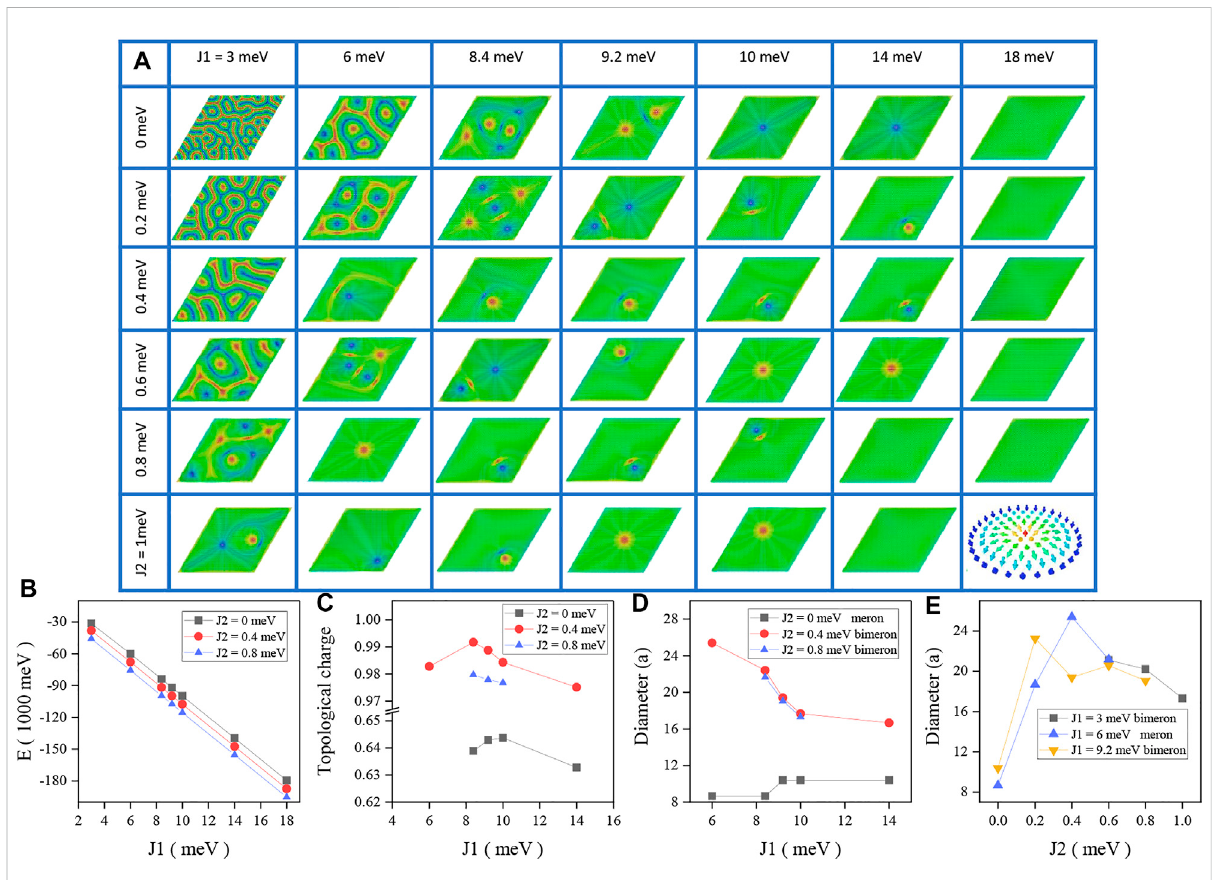
FIGURE 3 (A) Pro fi le of the magnetization of the fi nal state for different J 1 and J 2 in the presence of in-plane magnetic anisotropy. (B) Total energy, (C) topologicalcharge,anddiameterofskyrmion(inunitoflatticeconstanta)asafunctionof (D) the fi rst-nearest-neighborexchangeinteraction